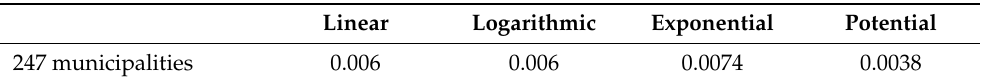
Table 7. R 2 value upon correlating MRW and average travel speed between villages and districts with their municipal capital (247 municipalities). Linear Logarithmic